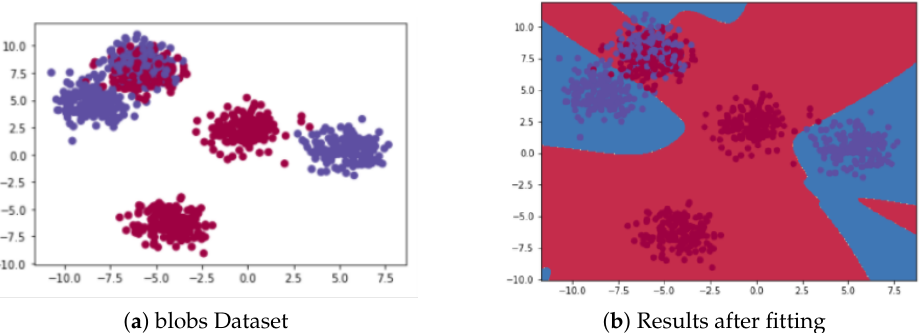
Figure 14. Visualization of the blobs dataset and results after fitting the DTBDNN model into the blobs